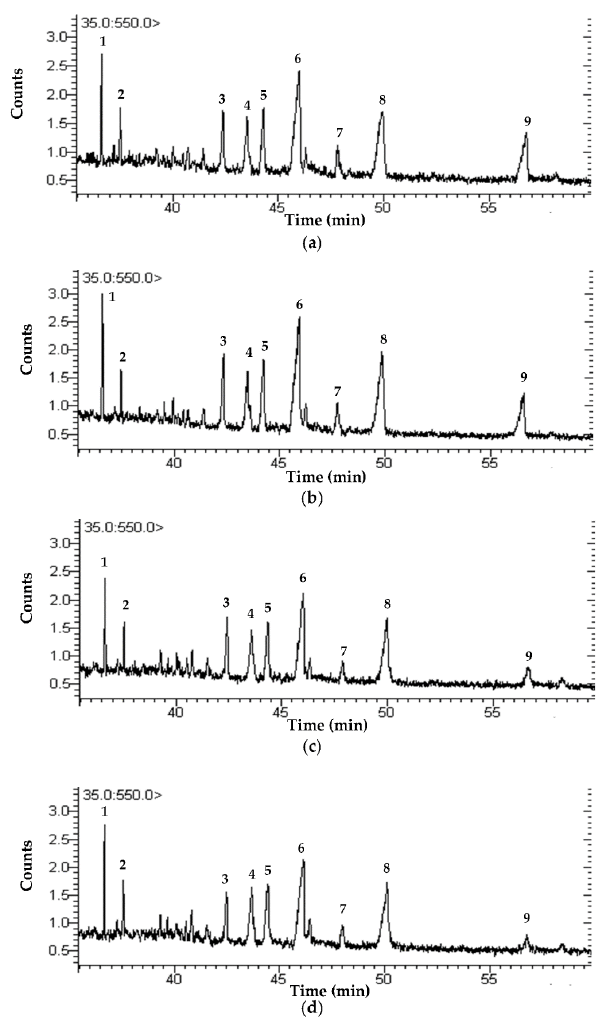
Figure 3. GC–MS chromatograms of CRBO from different extraction processes given the retention time of 35–60 min: ( a ) hexane extraction (HE); ( b ) cold press extraction (CE); ( c ) thermally pretreated cold press extraction (CCE); ( d ) ultrasound-pretreated cold press extraction (UCE). ( 1 ) squalene; ( 2 ) unidentified; ( 3 ) stigmasta-4,6,22-trien-3β-ol; ( 4 ) campesterol; ( 5 ) stigmasterol; ( 6 ) β-sitosterol; ( 7 ) cycloartenol acetate; ( 8 ) 24-methylenecycloartanol; and ( 9 ) propanoic acid, 3,3′-thiobis-, didodecyl ester. The relative percentage composition of campesterol, stigmasterol, and β-sitosterol in CRBO were between 20.31–25.69%, 20.44–23.52%, and 50.79–59.22% of total phytosterols,